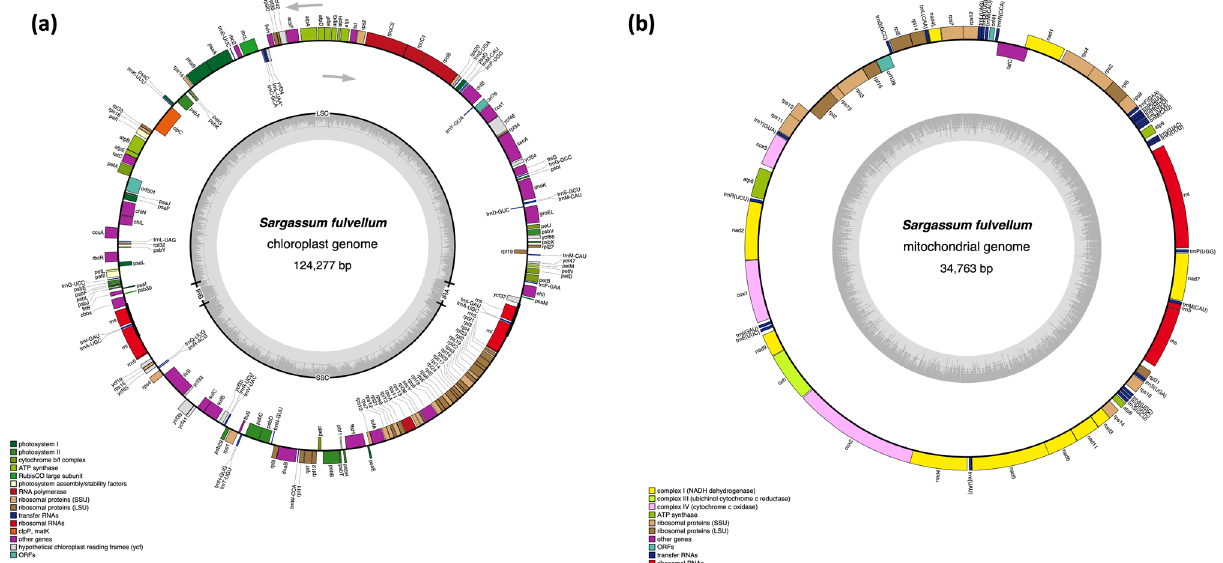
Figure 1. The organellar genome map of Sargassum fulvellum . The genes inside and outside of the circle are transcribed in clockwise and counterclockwise directions, respectively. The grey circle on the inside shows the GC content. The colored boxes represent gene functional groups. The thick lines in chloroplast genome map indicate the inverted repeats (IRa and IRb), which separate the genome into small (SSC) and large (LSC) single- copy regions. The chloroplast and mitochondrial genome maps of the other 5 species ( S. confusum , S. horneri , S. macrocarpum , S. serratifolium , and S. siliquastrum ) are shown in Fig. S2 and Fig. S3, respectively. Circular organellar genome maps were drawn using OGDRAW version 1.3.1 (https:// chlor obox. mpimp- golm. mpg. de/ OGDraw.